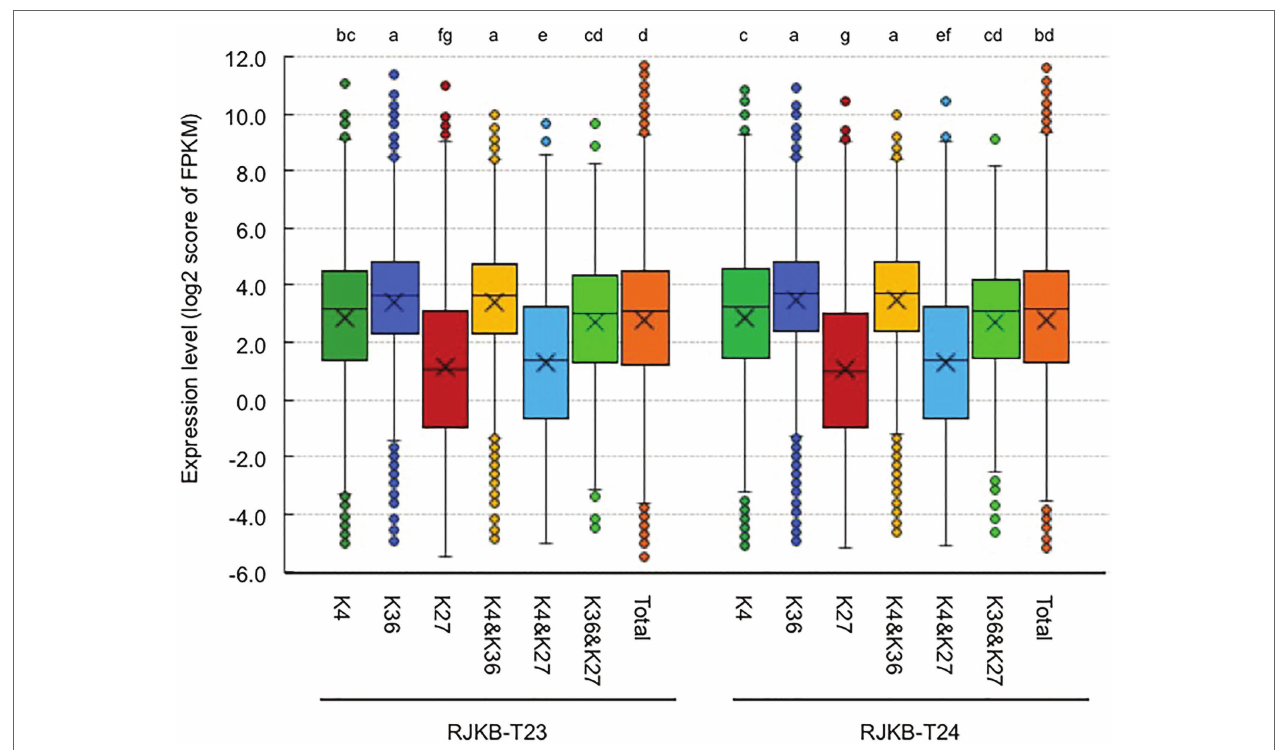
FIGURE 4 | Box plots of the gene expression levels of the log 2 score of FPKM with H3K4me3 (K4), H3K36me3 (K36), and H3K27me3 (K27) in genic regions of RJKB-T23 and RJKB-T24. “&” represents genes having two different histone marks. “Total” indicates the log 2 score of FPKM in all genes (FPKM < 0.01).